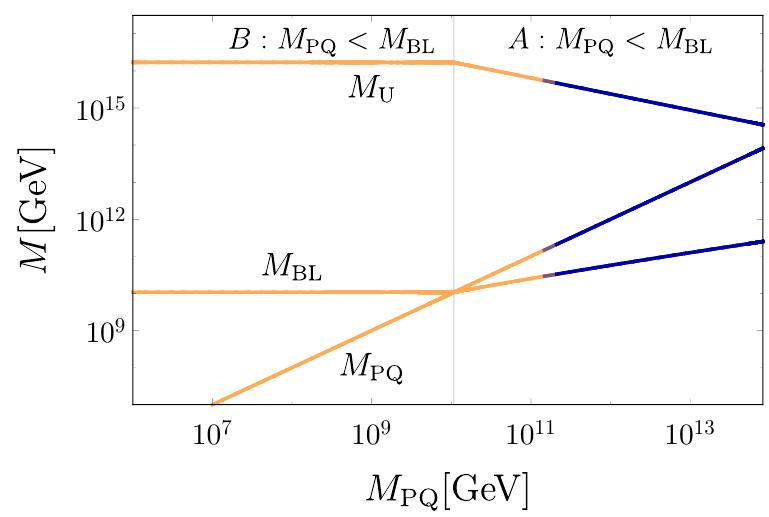
Figure 5 . Relationship between the three uni(cid:12)cation scales for the Model 2.1 described in (4.24) in the case of minimal threshold corrections. The regions in blue are excluded by the non-observation of proton decay. In case B, M PQ < M BL , M PQ is unconstrained - it can take any value, while the B-L breaking scale M BL is (cid:12)xed at (cid:24) 10 10 GeV. scales - we can only infer a relationship between the three uni(cid:12)cation scales M